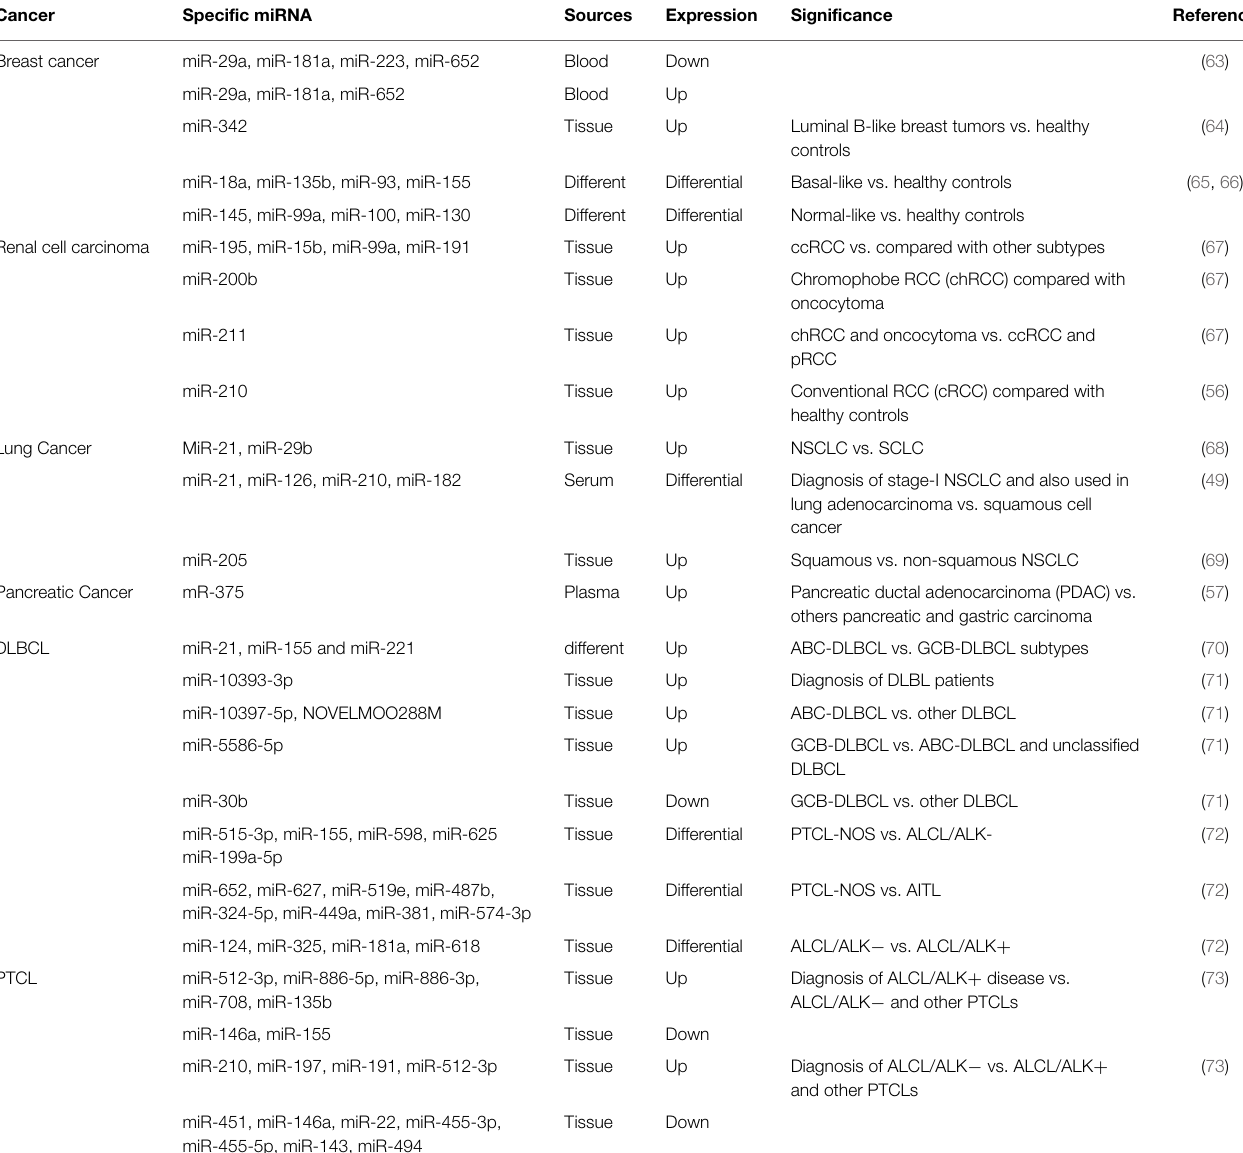
TABLE 2 | miRNA for tumors sub-typing